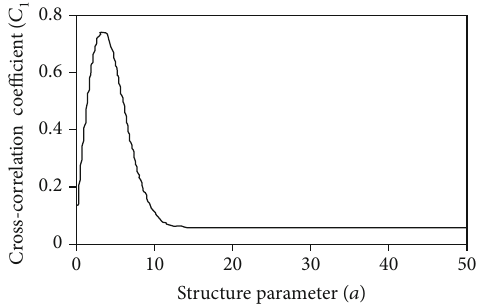
Figure 9: The relationship between the cross-correlation coe ffi cient C 1 and the structure parameter